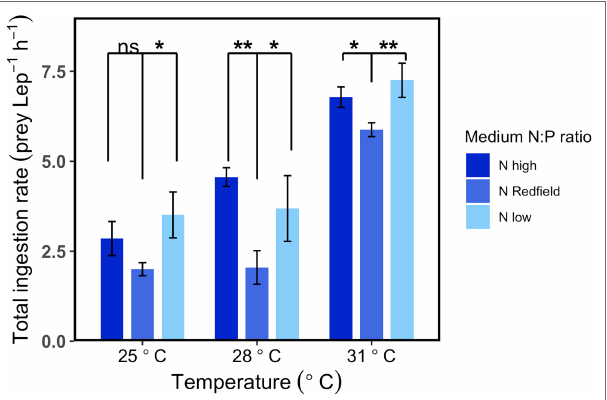
FIGURE 1 | The results of first-round selective feeding experiments conducted at 25 ° C. The total ingestion rate (A) , the ingestion rate on high-N and low-N prey (B) , and the Chesson selectivity index (C) of Lepidodinium sp. under N high (N:P ratio = 64), N Redfield (N:P ratio = 16), and N low (N:P ratio = 4) conditions at 25 ° C. The asterisk in (A) and (B) indicates the significant difference between specific groups, e.g., the high-N prey and low-N prey (Tukey HSD Test following a one-way ANOVA); the asterisk in (C) shows the difference of Chesson selectivity index from 0.5 (Student’s t -test; * p < 0.05; ** p < 0.01; *** p < 0.001; and ns: p > 0.05).